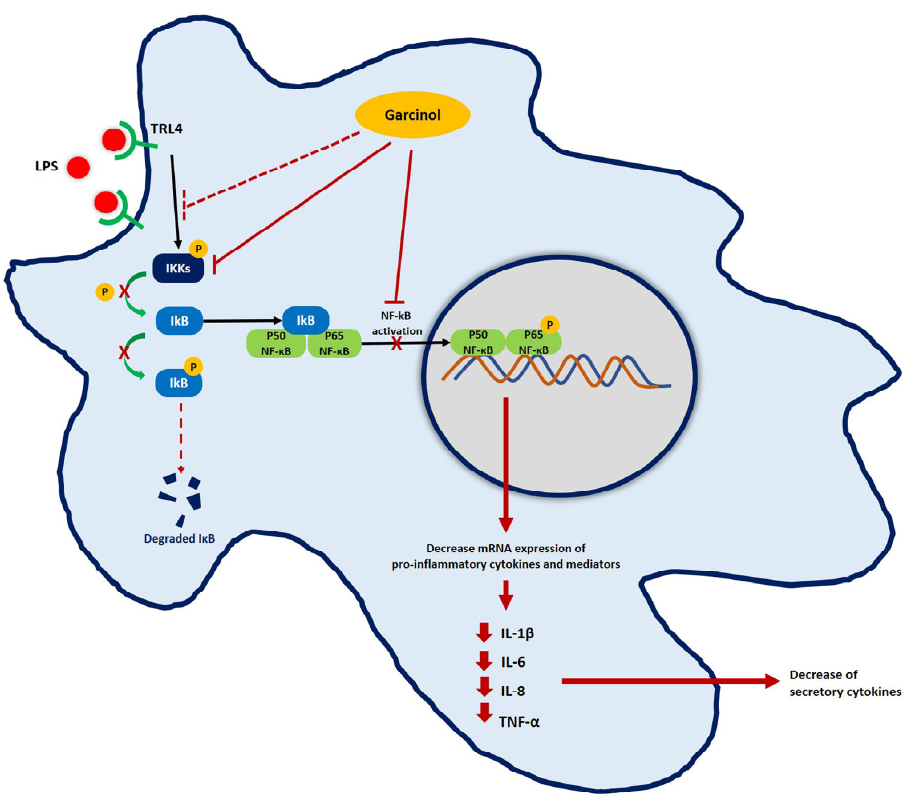
Figure 8. Proposed model for the anti-inflammatory activity of garcinol in macrophages. Black lines represent the standard response for LPS activation; red lines represent garcinol activity found in this present study; and red dashed lines represent the hypothesized activities of garcinol.